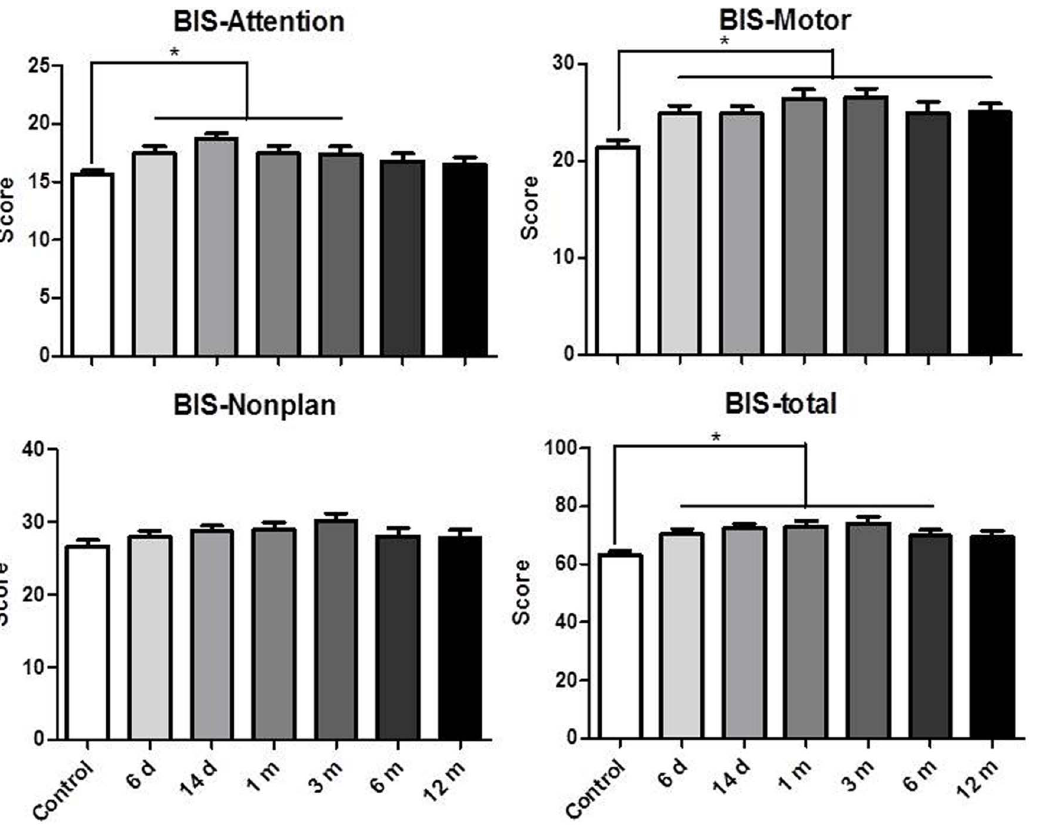
Figure 3. Self-reported impulsivity on the BIS-11 in the subjects. * p , 0.05, significant difference between METH abusers and healthy controls.